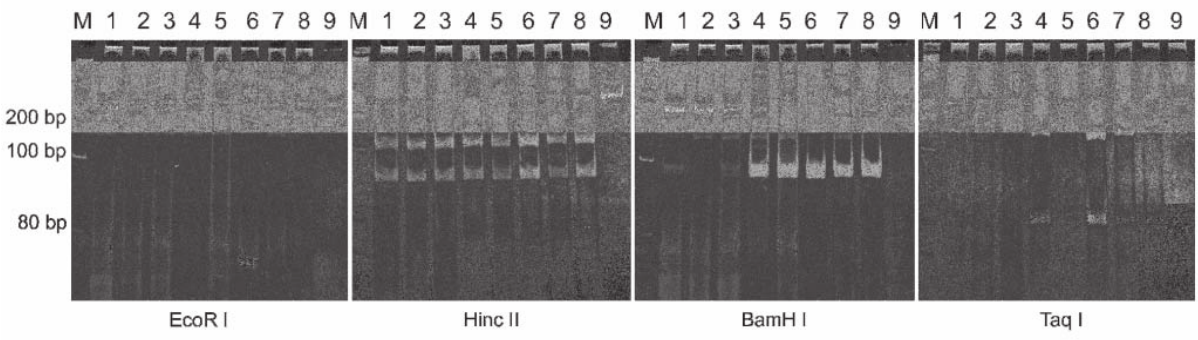
Fig. 1. Restriction fragment length polymorphism analysis of PCR products of eight Turkish Apple chlorotic leaf spot isolates. M, molecular weight marker (Lambda DNA/ Eco RI + Hind III, Marker 3, Fermentas GmbH, St. Leon- Rot, Germany); 1, KP2; 2, KP4; 3, KP5; 4, AP10; 5, AP62; 6, ASwC43; 7, ASwC44; 8, AP11; 9, control-DNA with no added